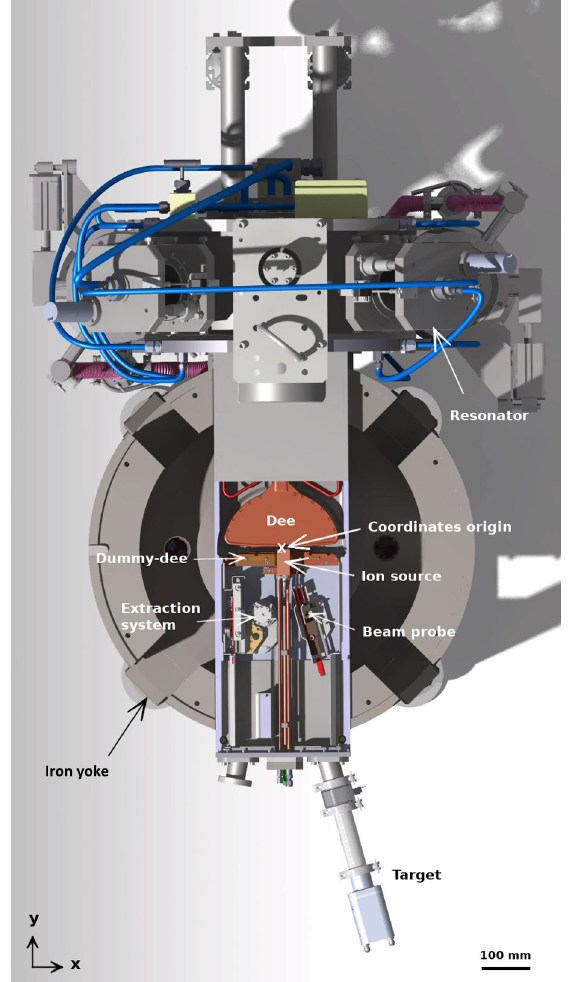
FIG. 2. Top view of the AMIT cyclotron 3D model. The main components, the center and the axes of the global reference frame and the scale are